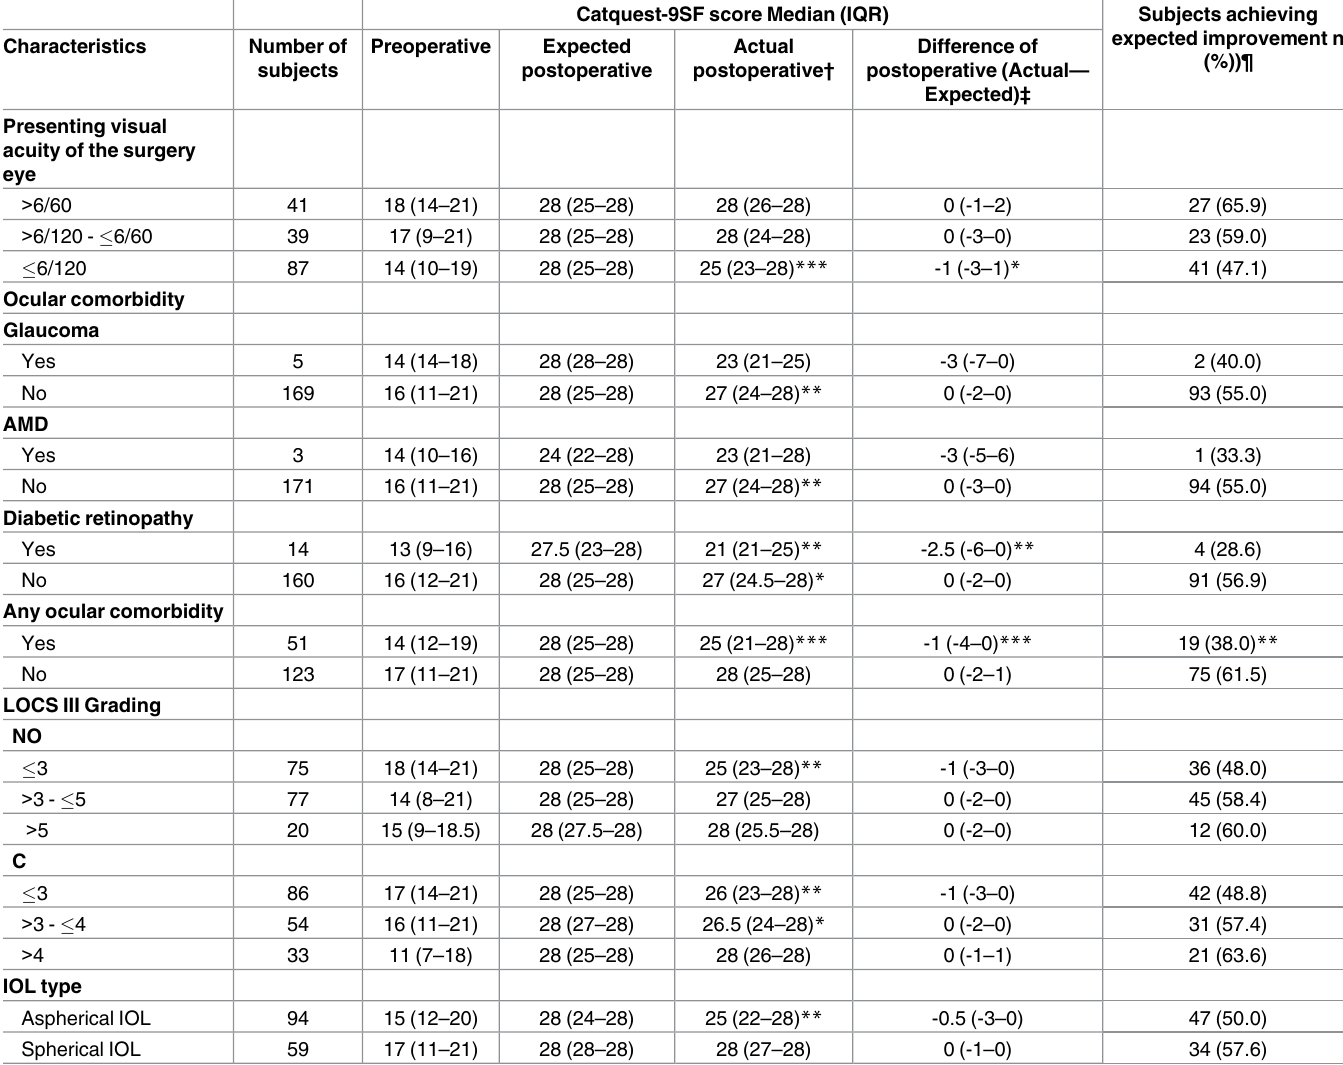
Table 3. Preoperativedifficulty, expected and actual postoperative improvement on the Catquest-9SF items by ocular characteristics (N =